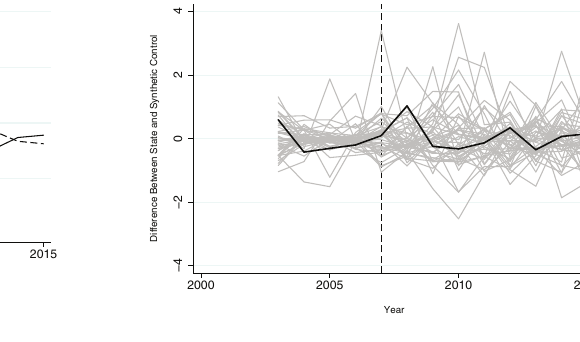
Native high-skilled female daily time spent on housework, gardening, and caring for